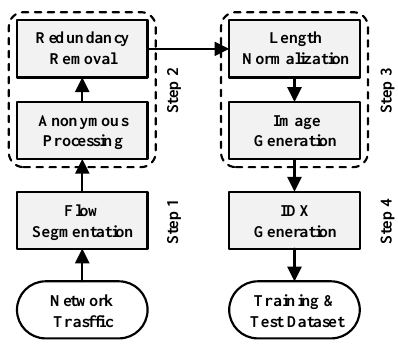
Figure 5. Network traffic preprocessing. Table 1. USTC-TFC2016 malware traffic.